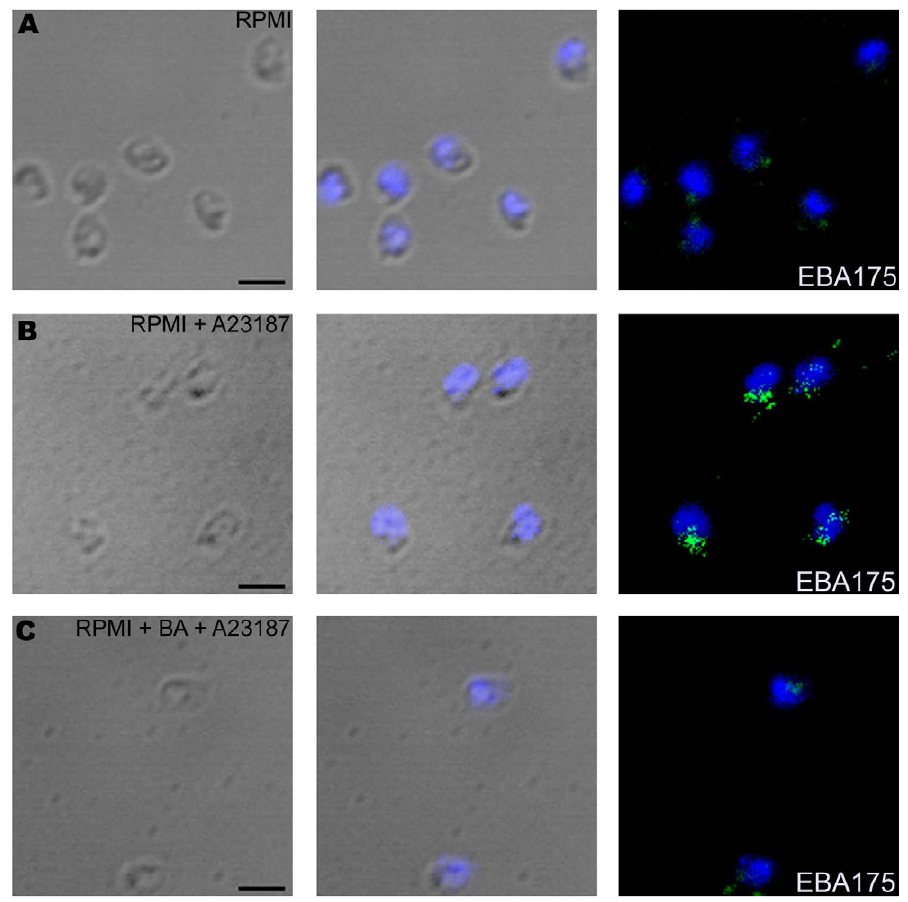
Figure 3. Expression of EBA175 on merozoite surface detected by immunofluorescence assay (IFA) following treatment with calcium ionophore A23187. Expression of microneme protein EBA175 on surface of P. falciparum merozoites isolated in RPMI1640 medium (RPMI) ( A ) or following treatment with either A23187 (RPMI + A23187) ( B ) or BAPTA-AM followed by A23187 (RPMI + BA + A23187) ( C ) was detected by IFA using anti-EBA175 rabbit sera followed by FITC-conjugated anti-rabbit IgG goat sera (green). Nuclear DNA was counterstained with DAPI (blue). Bright field, bright field merged with DAPI staining and merged fluorescence images (DAPI and FITC) are shown. Black bar indicates 2 m m.